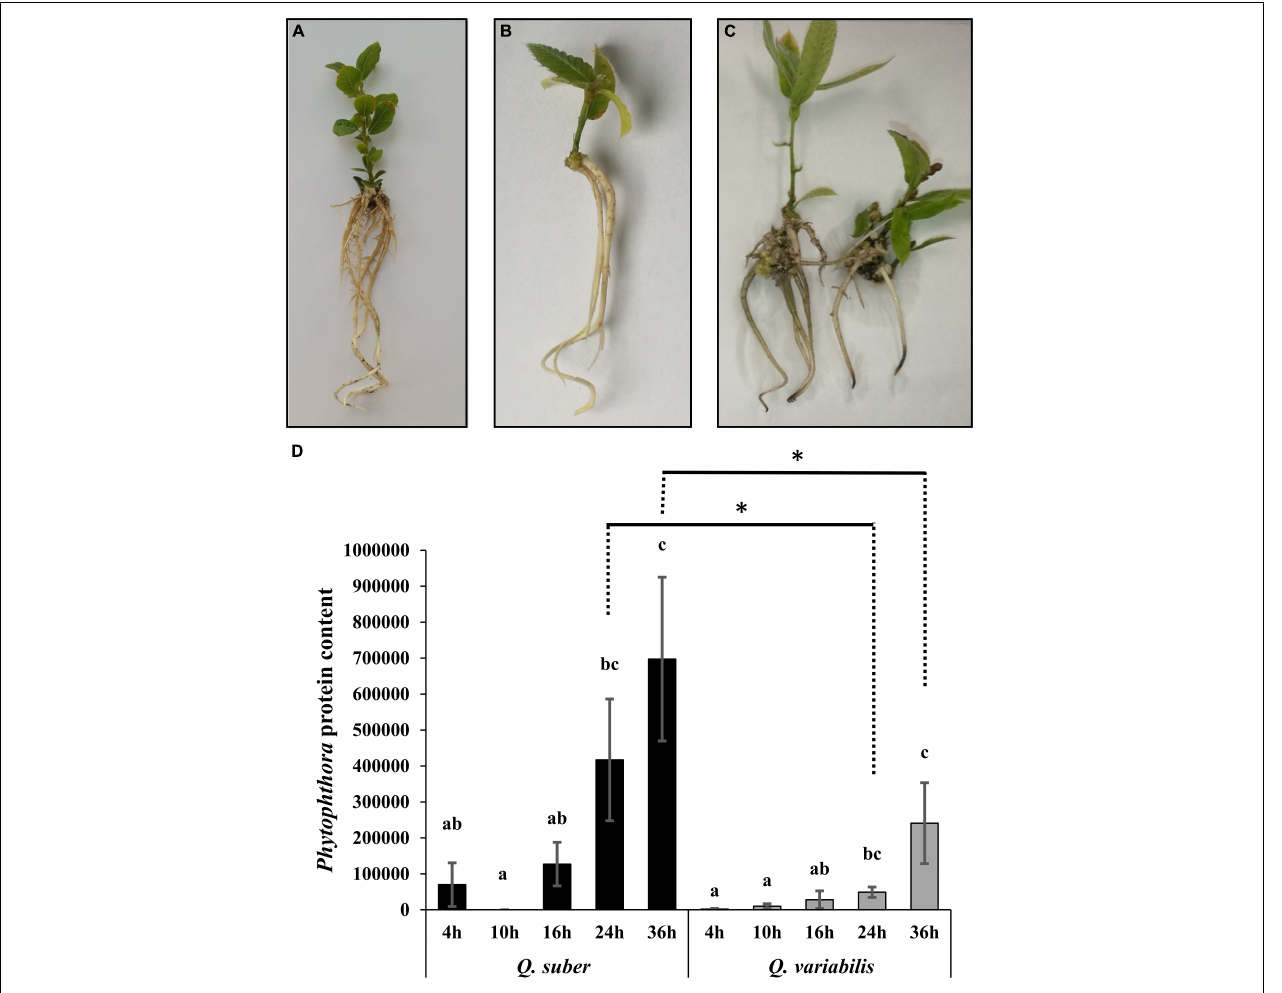
FIGURE 1 | Visual status of micropropagated Quercus suber (A) and Quercus variabilis (B) seedlings prior to the inoculation, and of Quercus variabilis 36 h after infection with Phytophthora cinnamomi (C) . Total Phytophthora -origin peptide content found in each root sample (D) . Different letters indicate statistically significant differences between time points within each species according to Kruskal–Wallis test ( p < 0.05). Asterisks indicate statistical differences between species for a given time point according to Kruskal–Wallis test ( p <